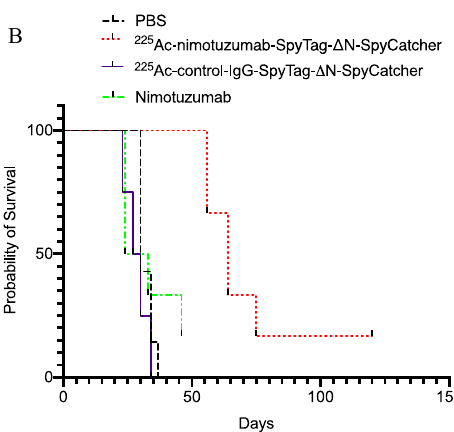
Figure 5. Efficacy of 225 Ac radioimmunoconjugate. ( A ) Tumor growth curves of treated ( 225 Ac-nimotuzumab-SpyTag- Δ N-SpyCatcher) and controls ( 225 Ac-control-IgG-SpyTag- Δ N-SpyCatcher; nimotuzumab or PBS). ( B ) Kaplan–Meier survival curves. Study endpoint occurred when the xenograft volume reached 2000 mm 3 . There were no significant differences ( p > 0.05) in tumor growth